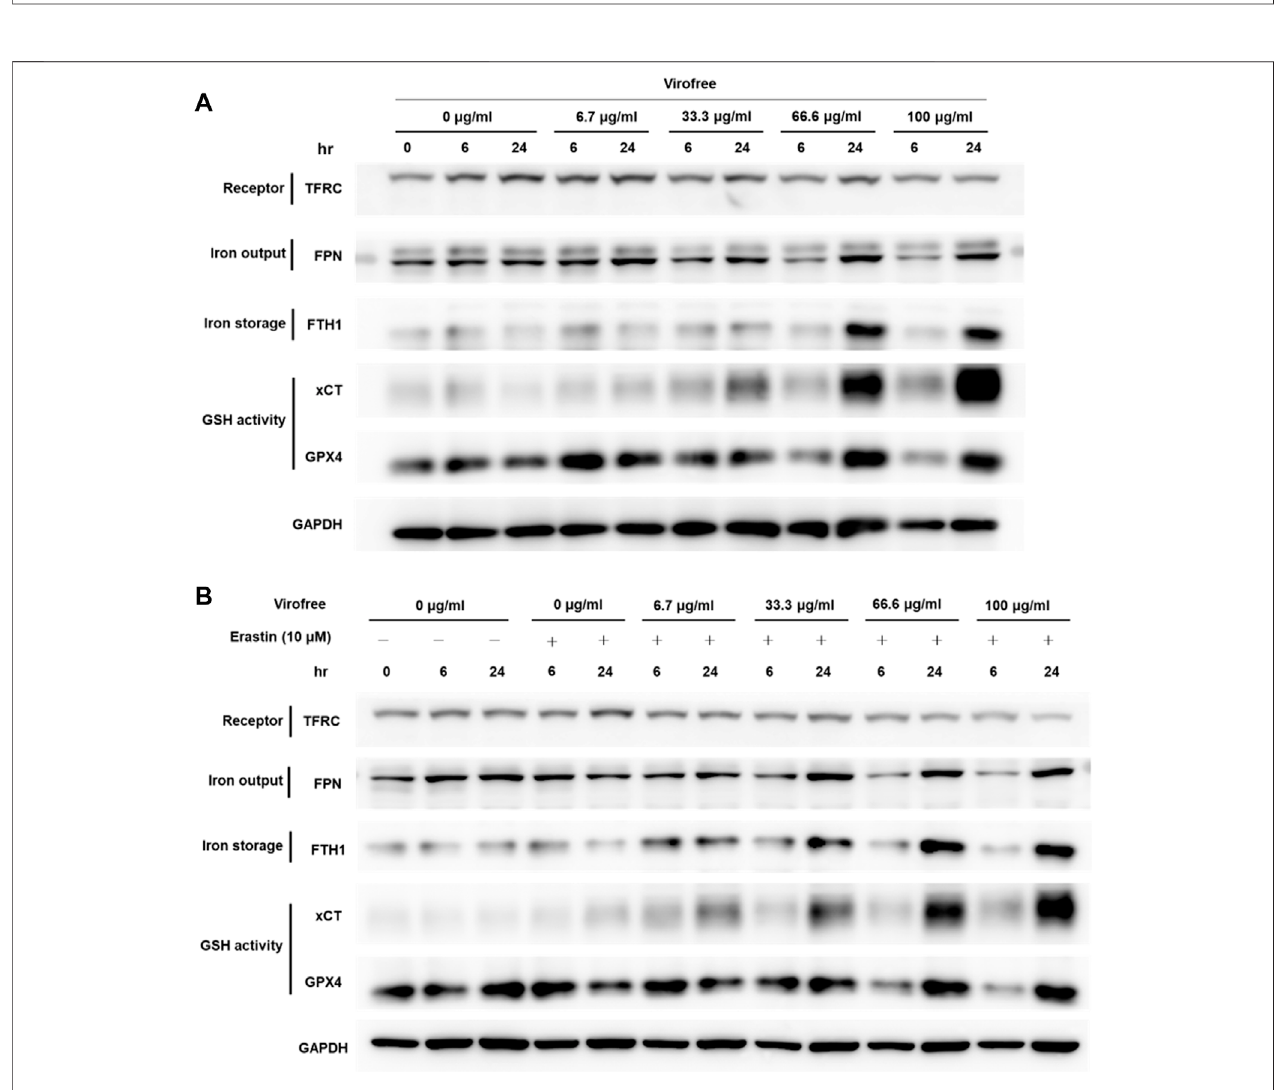
FIGURE 5 | Virofree has the potential to reduce the labile iron pool and protect the cells from ferroptosis in THP-1-derived macrophages. (A) THP-1-derived macrophages received treatments of different concentrations of Virofree for 6 or 24 h, respectively. Whole-cell lysates were prepared and subjected to Western blot analysis. GAPDH was used as an internal control ( n = 3). (B) THP-1-derived macrophages received treatments of different concentrations of Virofree in the presence of erastin(10 μ M)for6or24 h,respectively.Whole-celllysateswerepreparedandsubjectedtoWesternblotanalysis.GAPDHwasusedasaninternalcontrol( n =3).